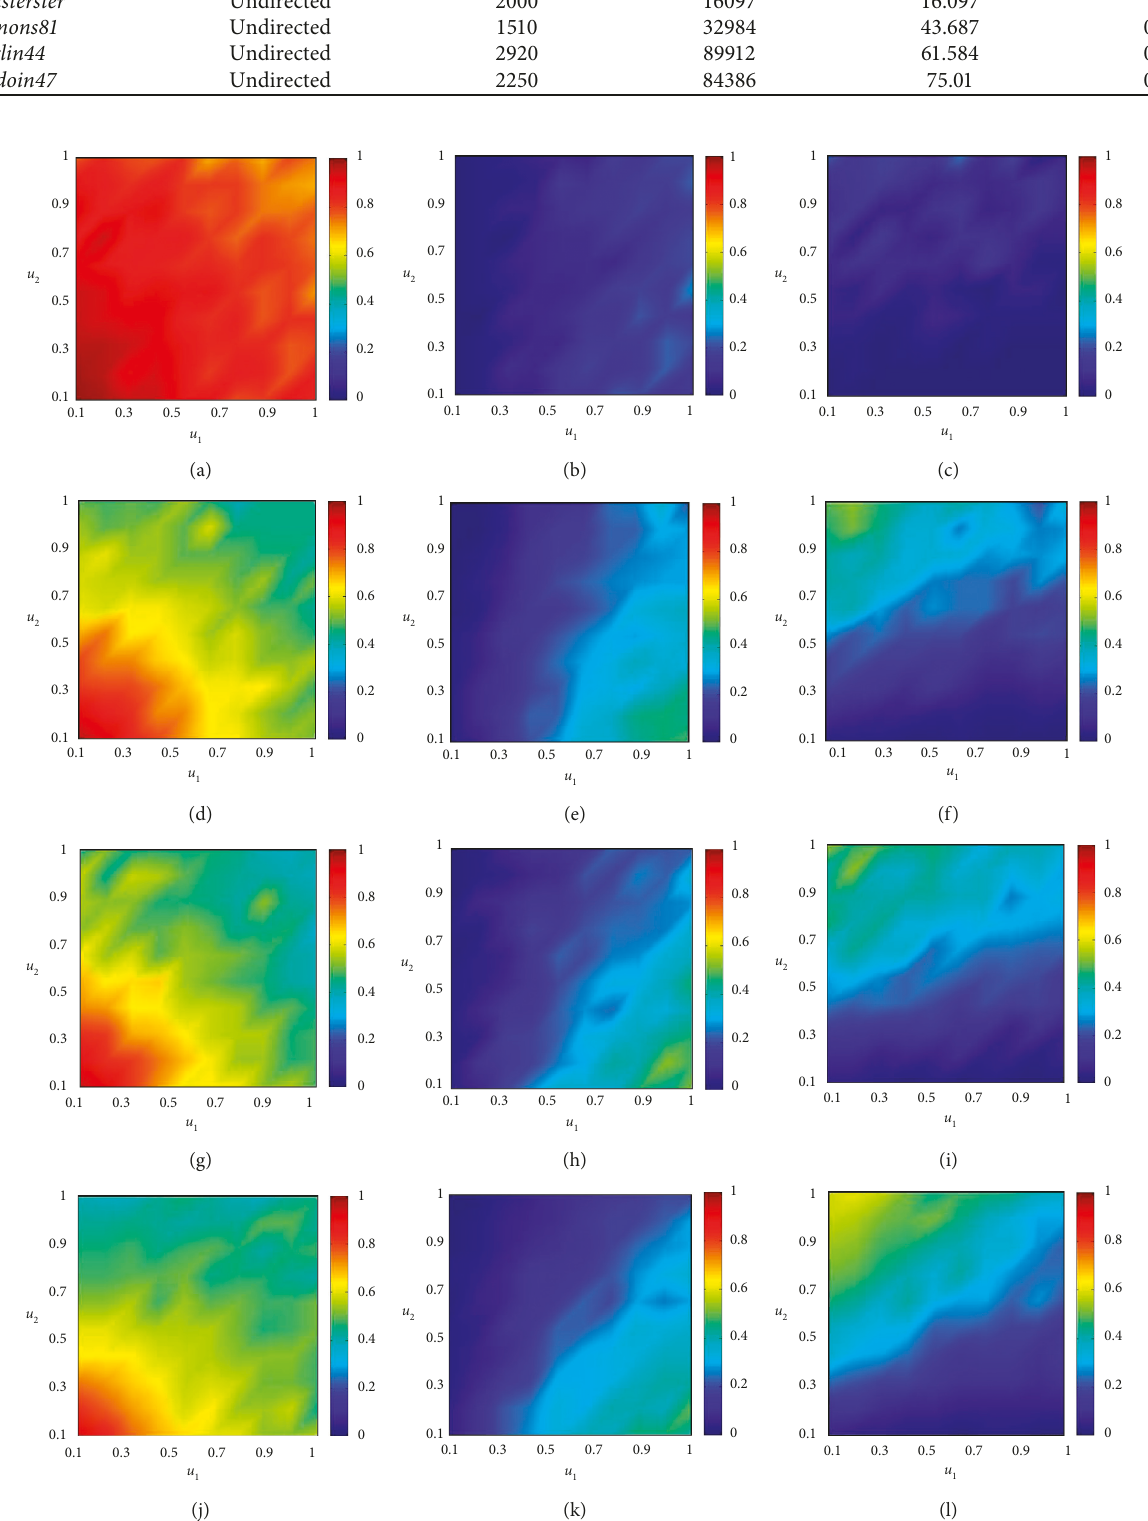
Figure 2: The values of ρ ε � 0.1. (a) ρ I of Hamsterster ; (b) ρ B (g) ρ I of Oberlin44 ; (h) ρ B